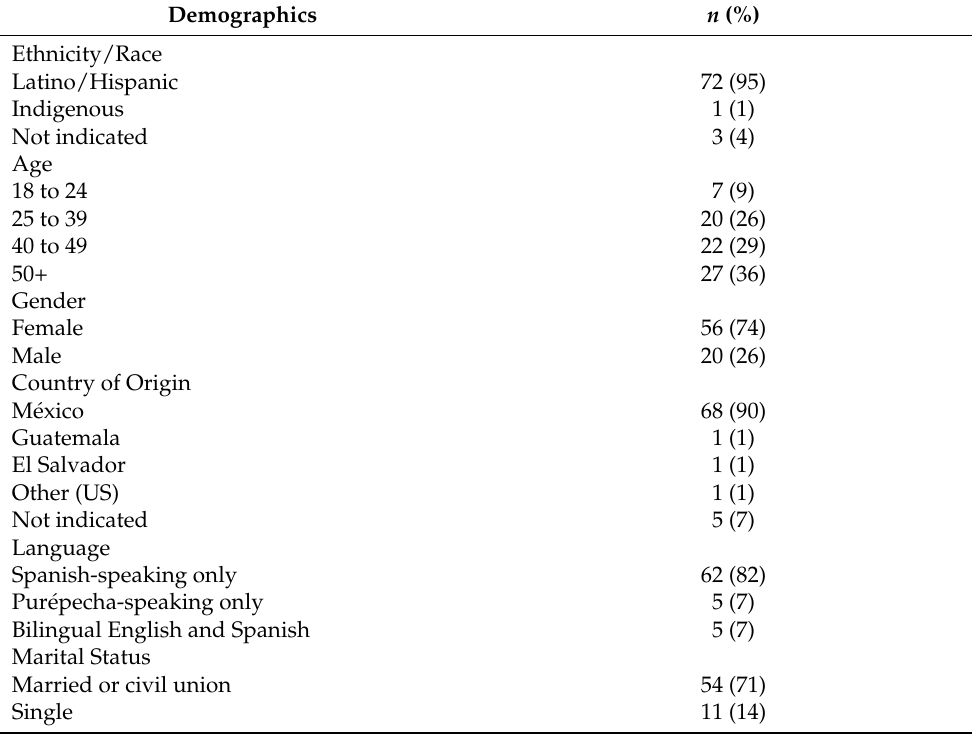
Table 2. Demographics and characteristics of participants ( n =